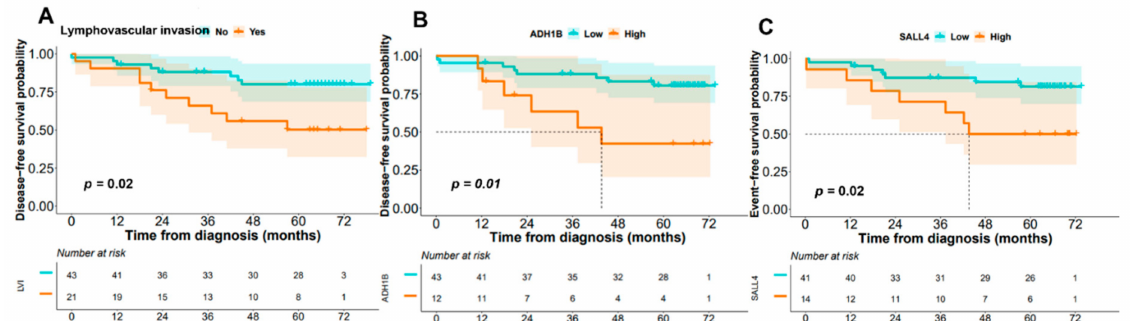
Figure 3. Histological and genetic features of sCRC patients showing the impact on disease-free survival (DFS) in the univariate analysis (n = 55). ( A ) Lymphovascular invasion, ( B ) ADH1B gene (NM_001286650), and ( C ) SALL4 gene (NM_001318031). Regarding OS, four mRNA dysregulated genes, ADH1B (NM_001286650) ( p = 0.03), MYLK (NM_053026) ( p = 0.01), BST2 ( p = 0.05), and FER1L4 ( p = 0.04), were the